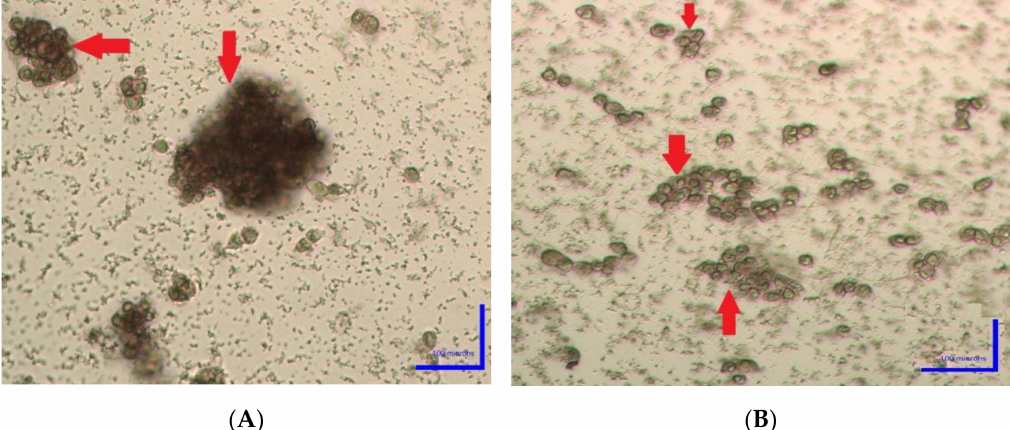
Figure 1. Nitro-blue tetrazolium (NBT) reduction test: ( A ) control cells (SHSY5Y cells without MLE); ( B ) SHSY5Y cells treated with MLE.